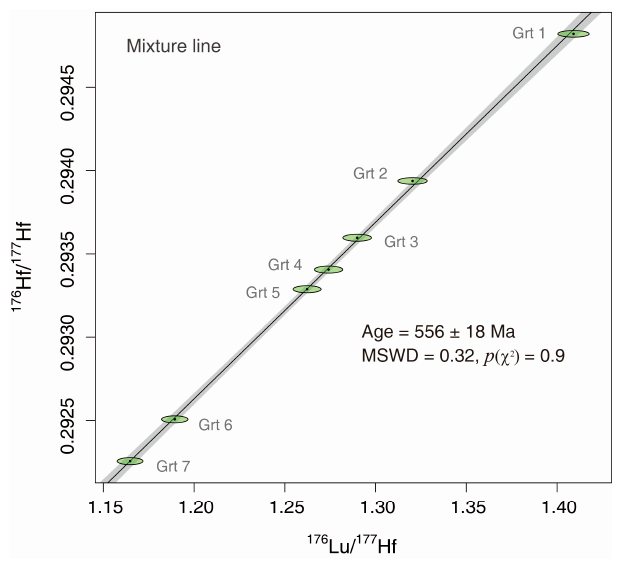
Figure 4. Mixture Lu–Hf errorchron diagram for the seven garnets.